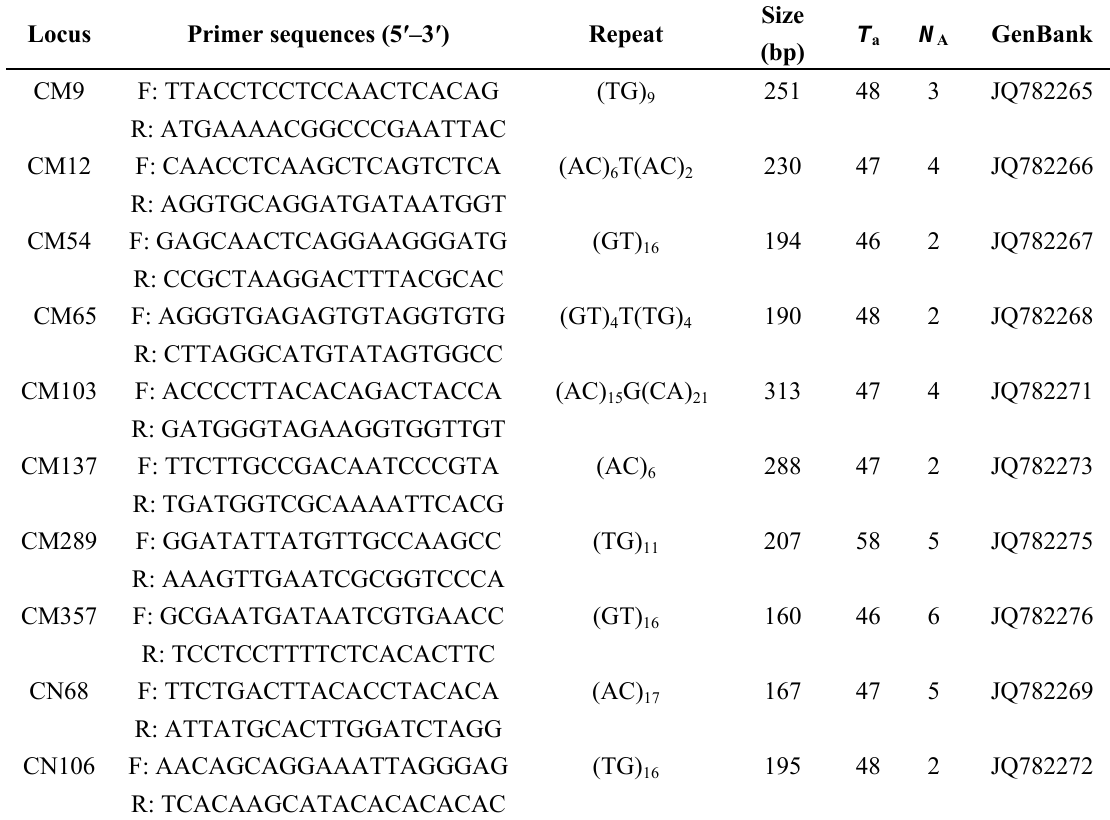
Table 2. Characteristics of ten microsatellite markers based on 61 Clivia accessions. For each locus, the names, primer sequences [forward (F) and reverse(R)], repeat motif, size of the cloned allele, annealing temperature, number of alleles and GenBank accession number are